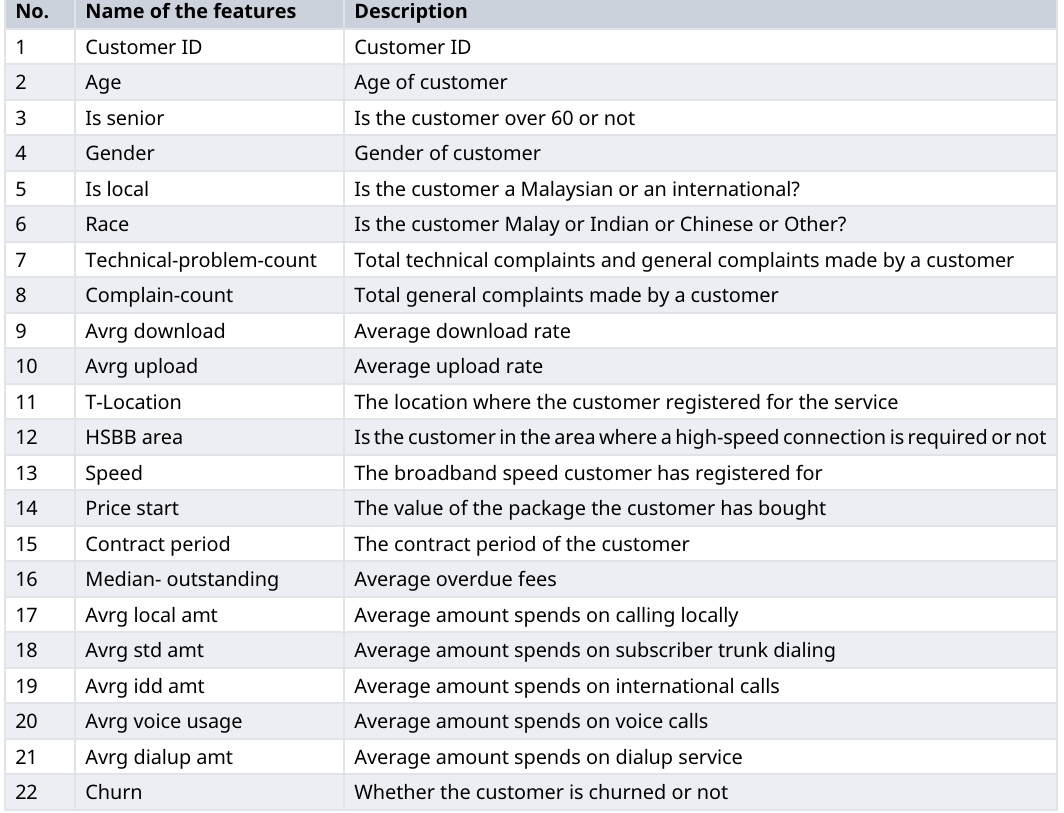
Table 2. Features used in the real-world dataset.